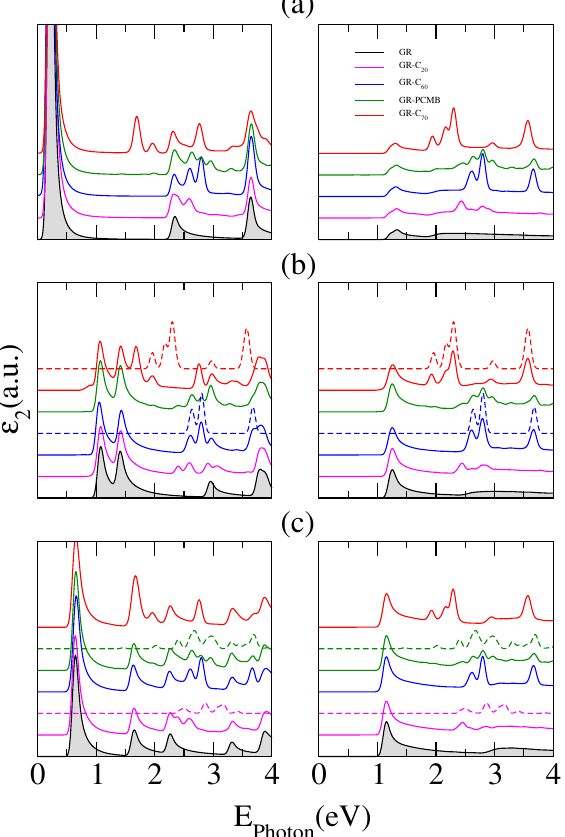
Figure 6. Imaginary part of the dielectric constant for fullerenes adsorbed on ( a ) 8GR; ( b ) 10GR and ( c ) 12GR nanoribbons. The curves in each panel have been vertically shifted for clarity. The spectra of the pristine nanoribbons are shadowed in gray and the spectra of bare fullerenes are displayed in dashed curves. The left panels are for parallel light polarization and the right panels for perpendicular light